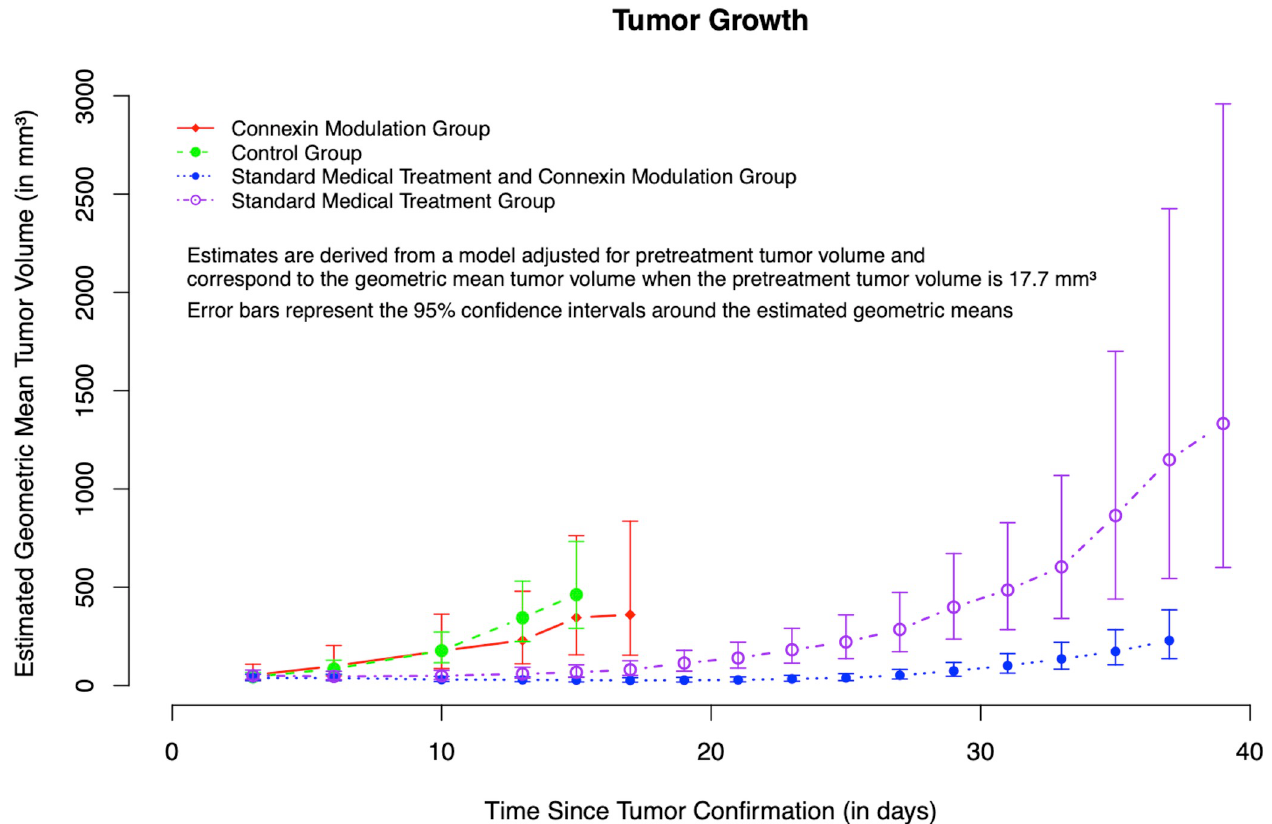
Fig 2. Graphical visualization of tumor growth per treatment group. Estimated geometric mean tumor volumes according to treatment group as a function of time since tumor confirmation in days for animals with a geometric mean pretreatment tumor volume of 17.7 mm 3 .